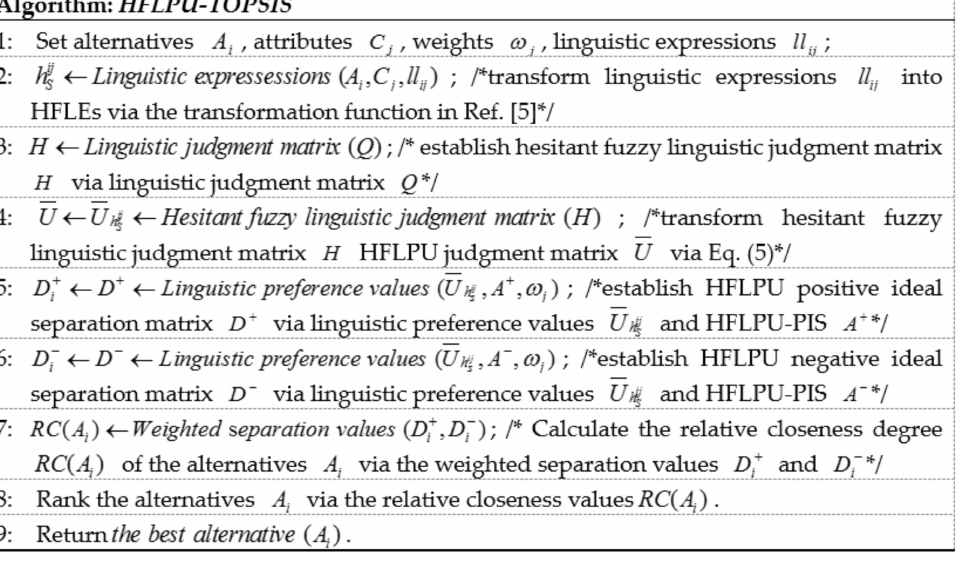
Figure 3. The pseudocode of the HFLPU-TOPSIS